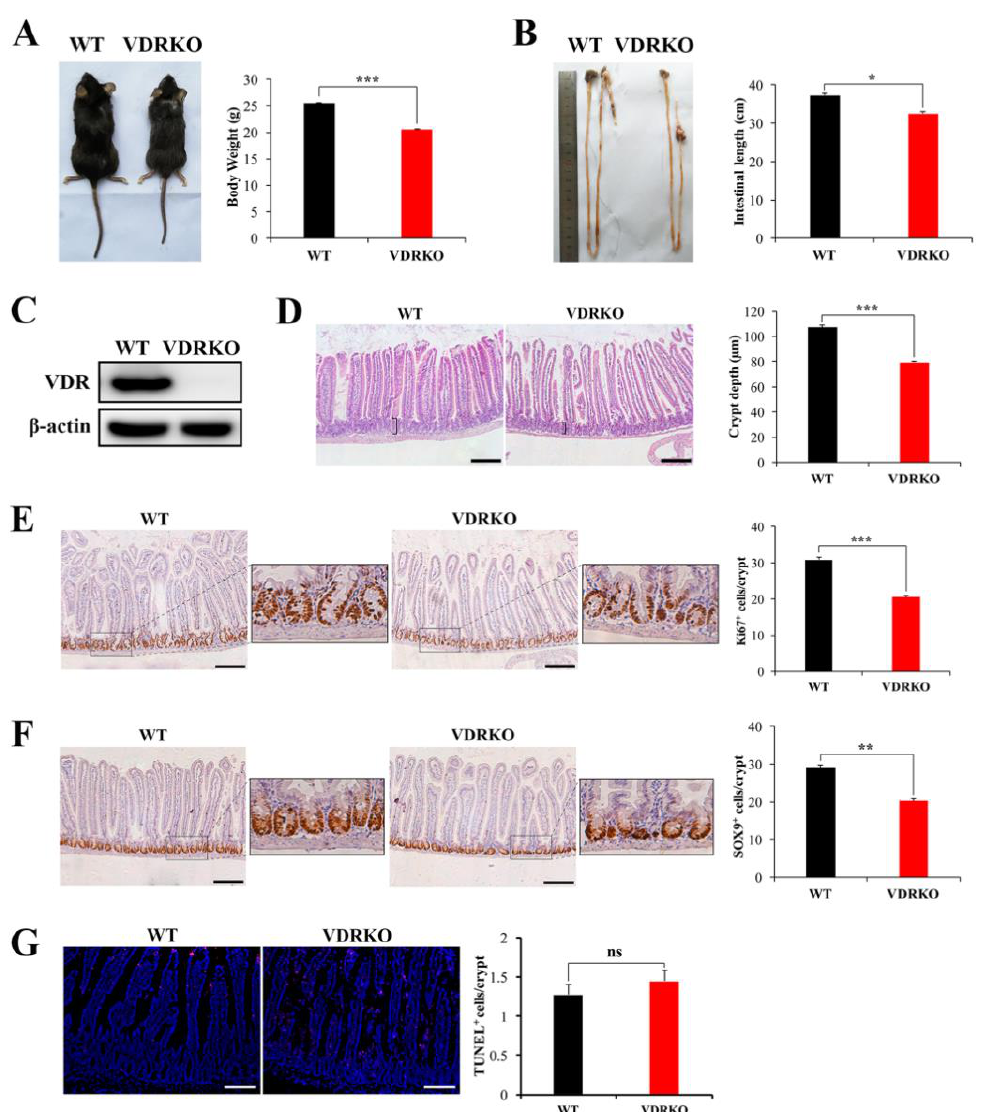
Figure 3. VDR deficiency impairs the intestinal physiological structure and crypt stem/progenitor cell proliferation. ( A ) Appearance of wild type (WT) and VDR knockout (VDRKO) mice and quantification of body weights at the age of 8 weeks. n = 12 in each group. ( B ) Appearance of intestines of WT and VDRKO mice and quantification of intestine length. n = 7 in each group. ( C ) VDR was evaluated in intestine tissues of mice by WB. ( D ) Representative H&E images of intestine of WT and VDRKO mice and quantification of crypt depth. n = 6 in each group. Scale bar, 200 μm. ( E ) Representative IHC images of Ki67 staining of WT and VDRKO mice and quantification of number of Ki67 + cells/crypt. Scale bar, 200 μm. n = 6 in each group. ( F ) Representative IHC images of SOX9 staining of mice and quantification of number of SOX9 + cells/crypt. n = 6 in each group. Scale bar, 200 μm. ( G ) Representative IF images of TUNEL staining of WT and VDRKO mice and quantification of TUNEL + cells/crypt. n = 6 in each group. Scale bar, 100 μm. Values are means ± SD. * p < 0.05, ** p < 0.01, *** p < 0.001.